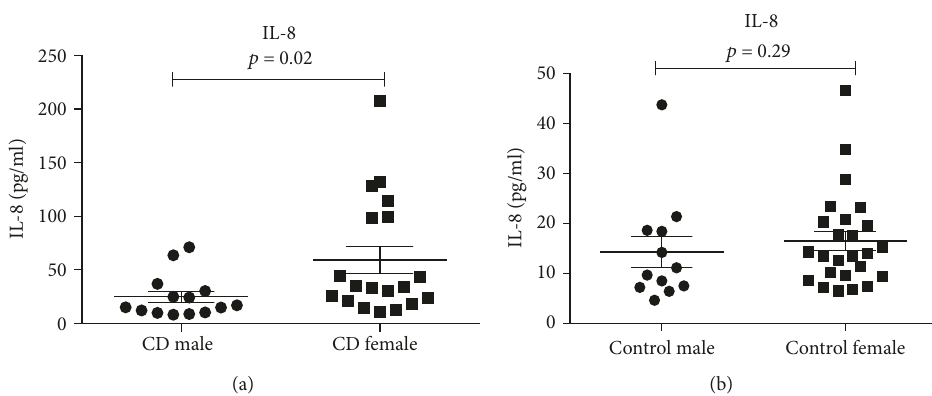
Figure 2: Comparison of the level of IL-8 (pg/ml) (median values and interquartile range) between males ( n = 14 ) and females ( n = 19 ) in CD patients using the Mann-Whitney U test (a). Comparison of the level of IL-8 (pg/ml) (median values) in male ( n = 12 ) and female ( n = 25 ) control persons using the Mann-Whitney U test ( P = 0 29 ) (b). Every dot represents the value of IL-8 in pg/ml for one